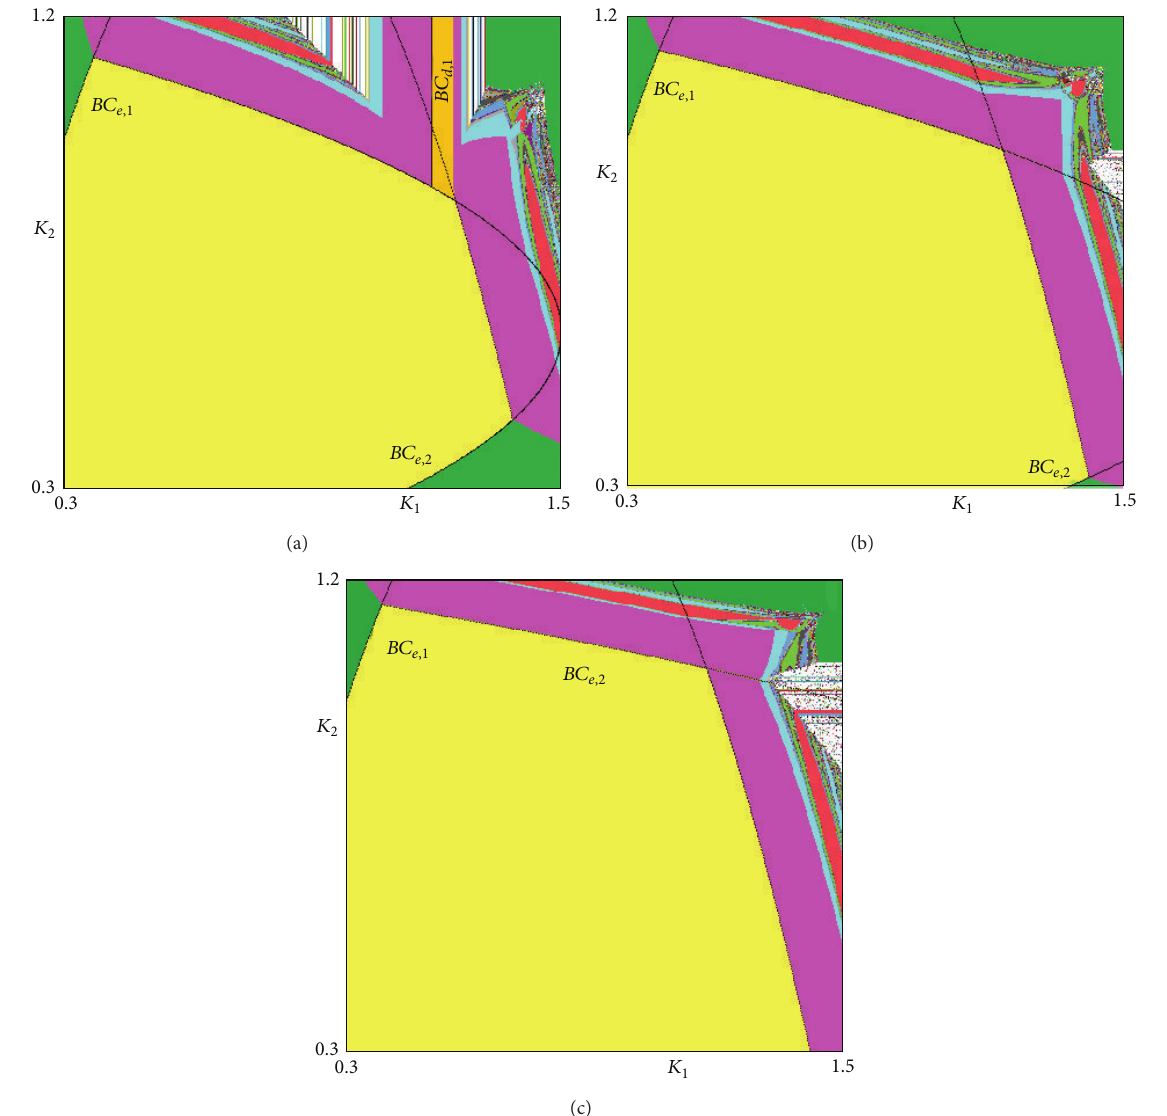
Figure 10: Two-dimensional bifurcation diagram on the (𝐾 1 , 𝐾 2 ) -parameter plane for map 𝑇 at 𝑁 1 = 1.5 , 𝑁 2 = 1.2 , 𝜏 1 = 4 , and 𝛾 1 = 𝛾 2 = 1 . Panel (a) 𝜏 2 = 5 . Panel (b) 𝜏 2 = 6 . Panel (c) 𝜏 2 = 8 . The meaning of the colors of the regions is as in Figure